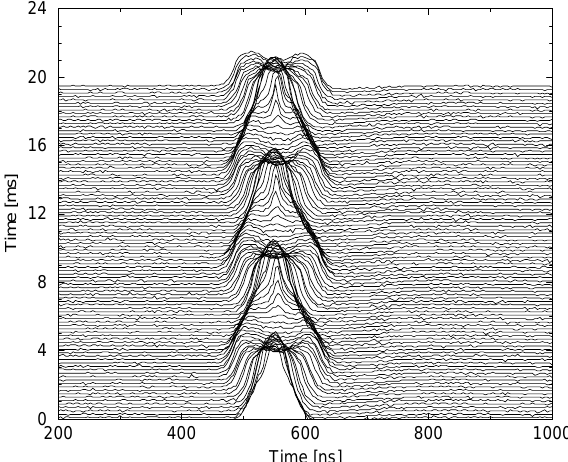
FIG. 3. Typical scope signals with the modulated rf voltage signal, the beam peak detector signal, and the beam current signal. The time scale on the horizontal axis is 0.1 sec (cid:3) div.